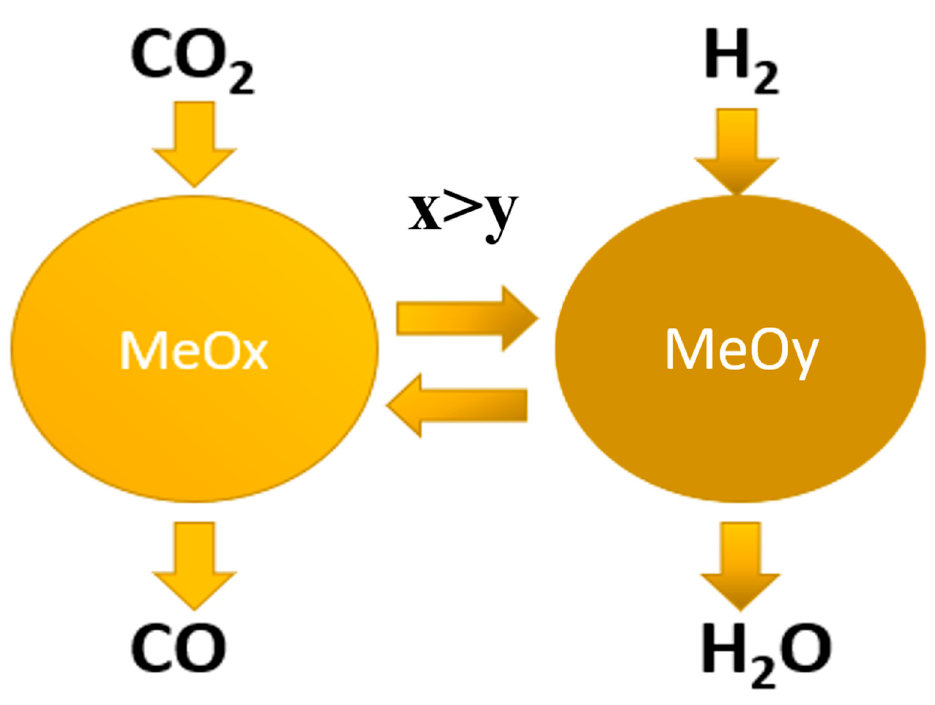
Scheme 1. Principal scheme of reverse water-gas shift chemical looping (RWGS-CL)